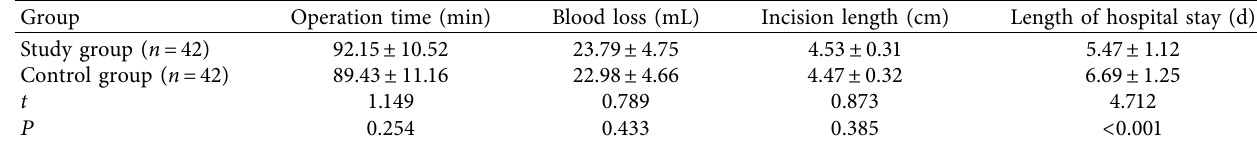
Table 6: Comparison of surgical indexes between the two groups ( x ± S